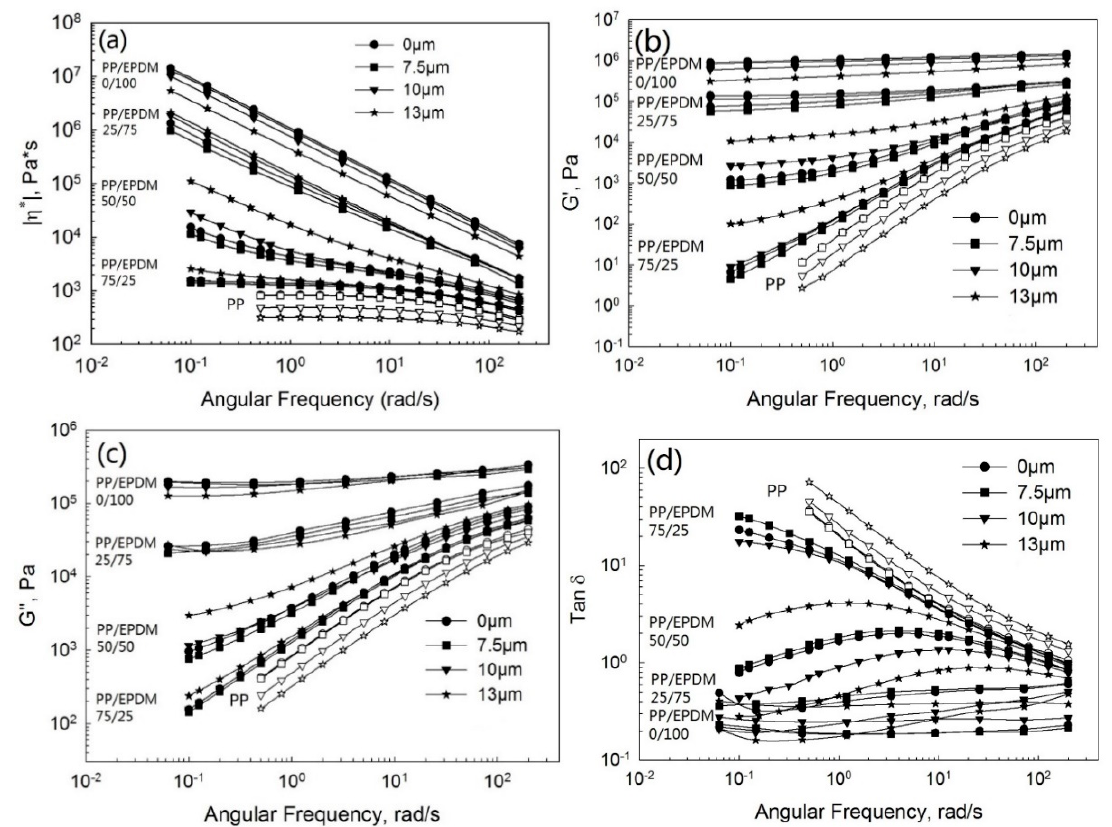
Figure 6. Complex viscosity ( a ), storage modulus ( b ), loss modulus ( c ), and loss tangent ( d ) as a function of the frequency at various ultrasonic amplitudes for the pure PP, devulcanized EPDM, and PP/EPDM blends prepared by the DR method.